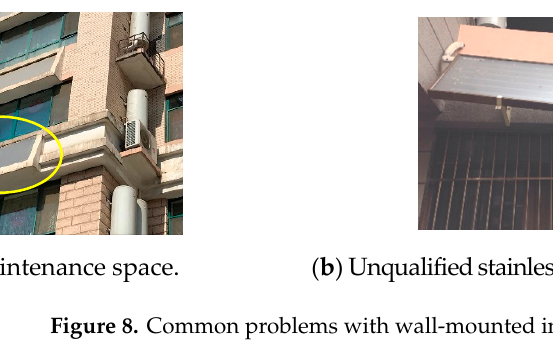
Figure 7. Collectors used as part of the outside windows.